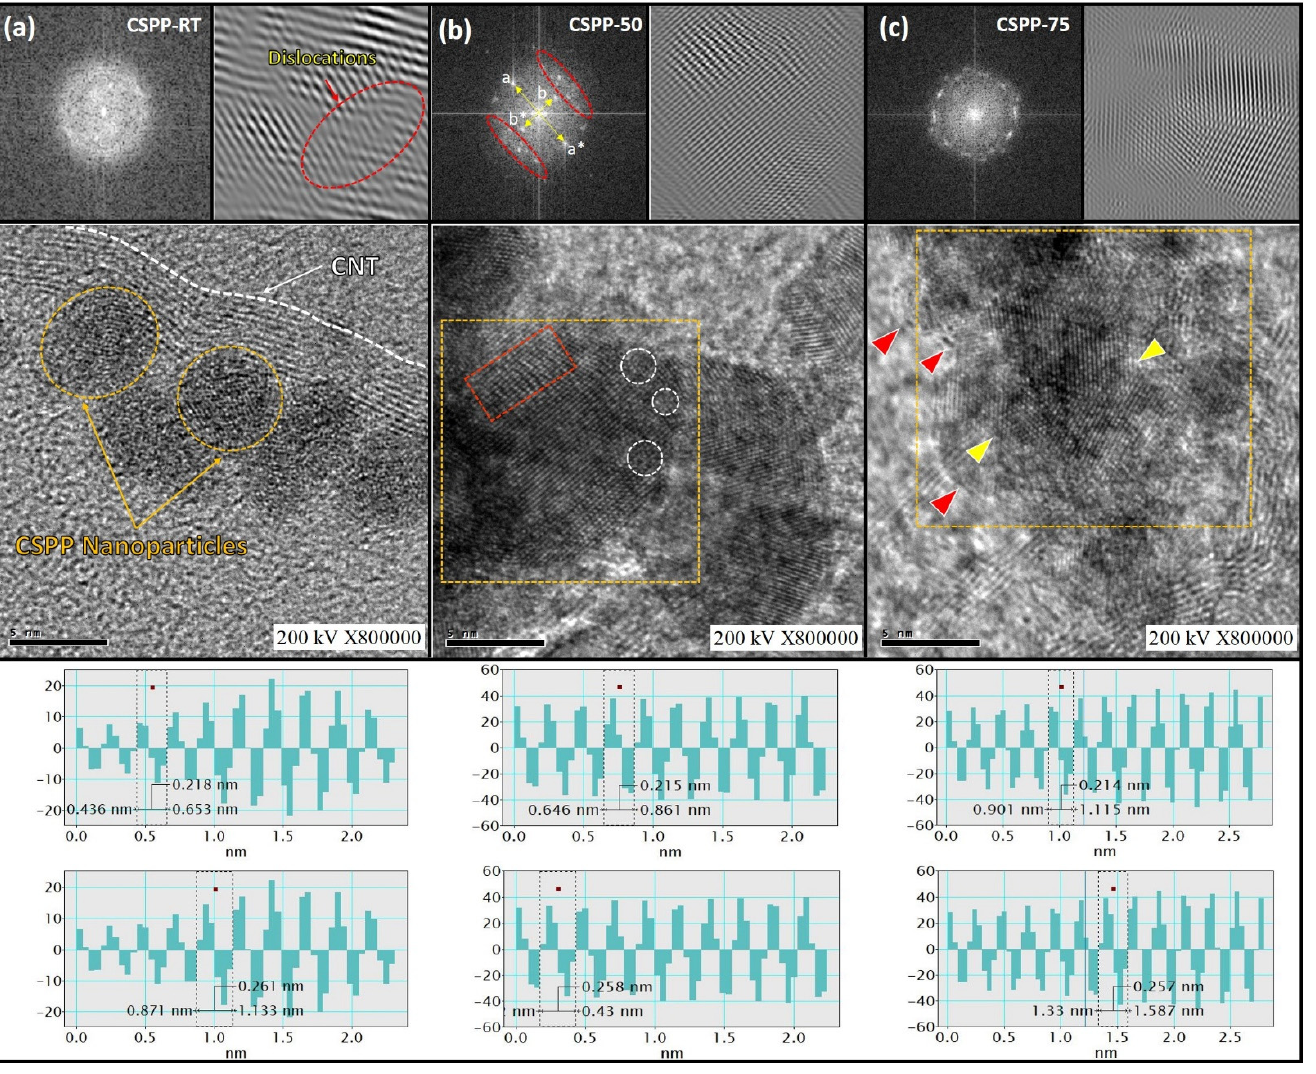
Figure 1. HRTEM images of CSPP NCs ( a ) CSPP-RT, ( b ) CSPP-50 and ( c ) CSPP-75. The interlayer spacings of CSPP NCs are calculated by using Inverse Fourier Transformed (IFT) images and their corresponding line histograms (insets). The Fourier transformation (FFT) pattern of the selected area in HRTEM images is shown in the upper left corners.